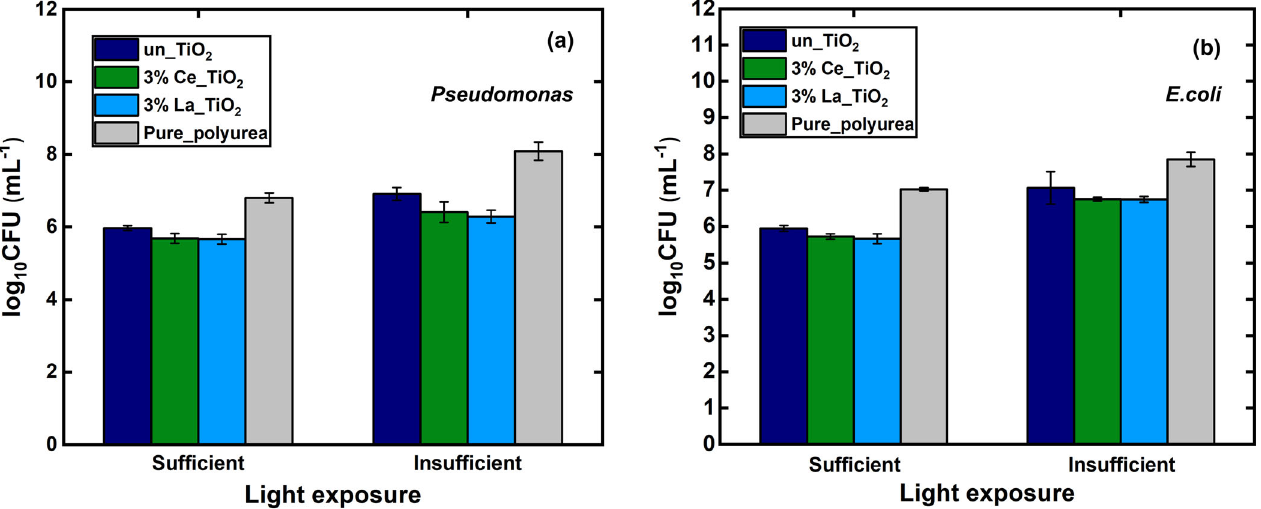
Fig. 9 Increment of antibacterial effect with different light exposure within different bio fi lm reactors. a E. coli CDC-reactor and b Pseudomonas CDC-reactor & Increment of antibacterial effect with higher environmental temperatures within E. coli CDC-reactor and Pseudomonas CDC-reactor.